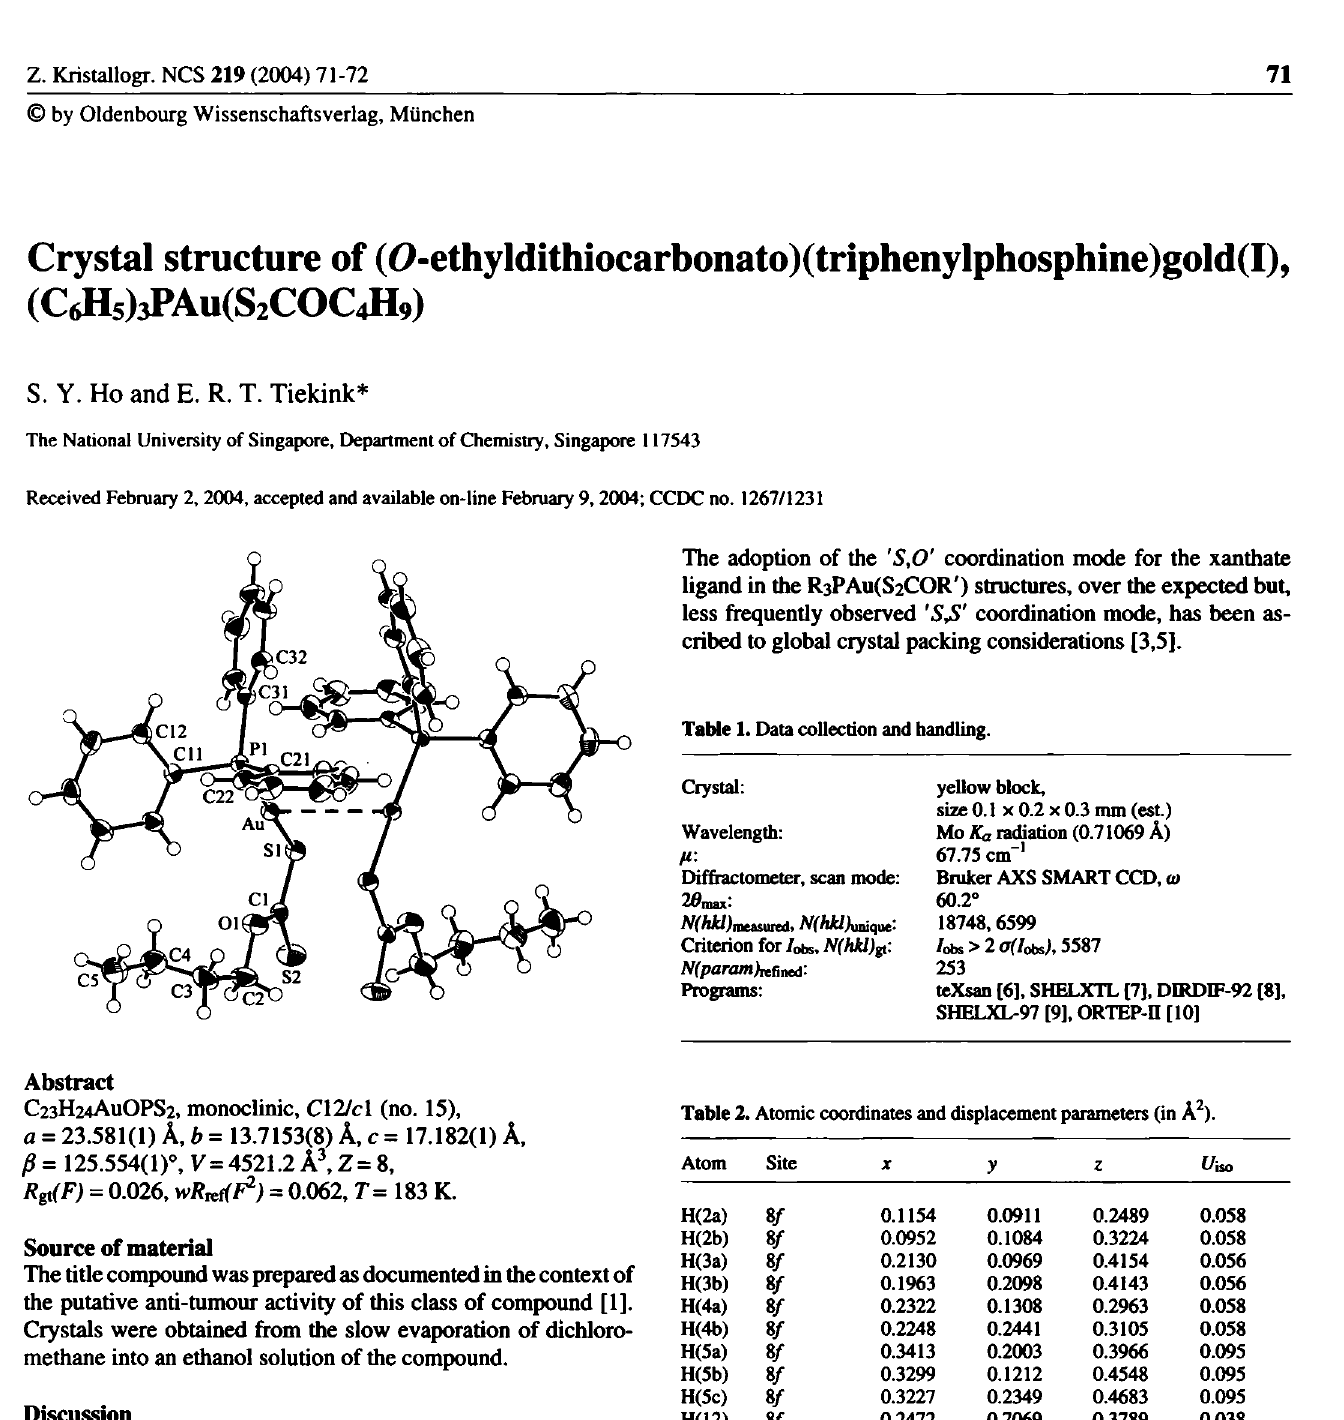
Table 2. Atomic coordinates and displacement parameters (in Â 2